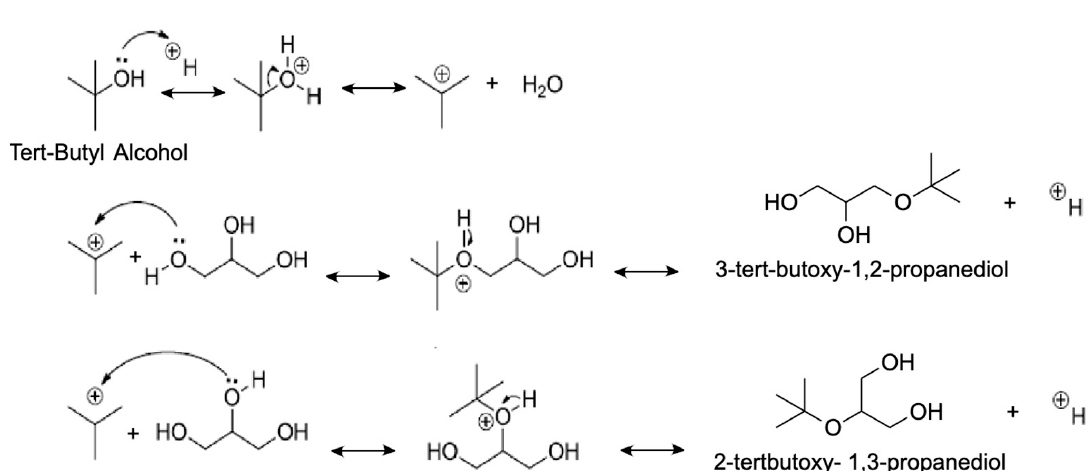
Figure 6. Suggested process in developing 3-tert-butoxy-1,2-propanediol and 2-tertbutoxy-1,3-propanediol through absorbing tert-butyl alcohol upon acid regions [118].